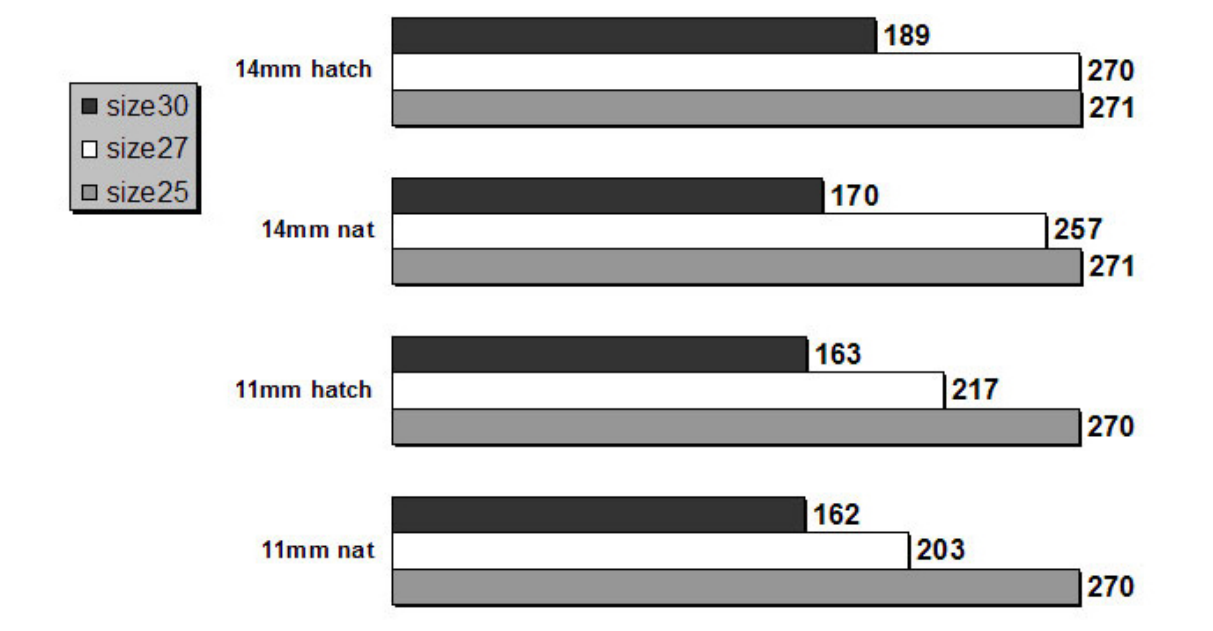
Fig. 6. Externalities [euro/ha/year] computed varying seeding and harvesting